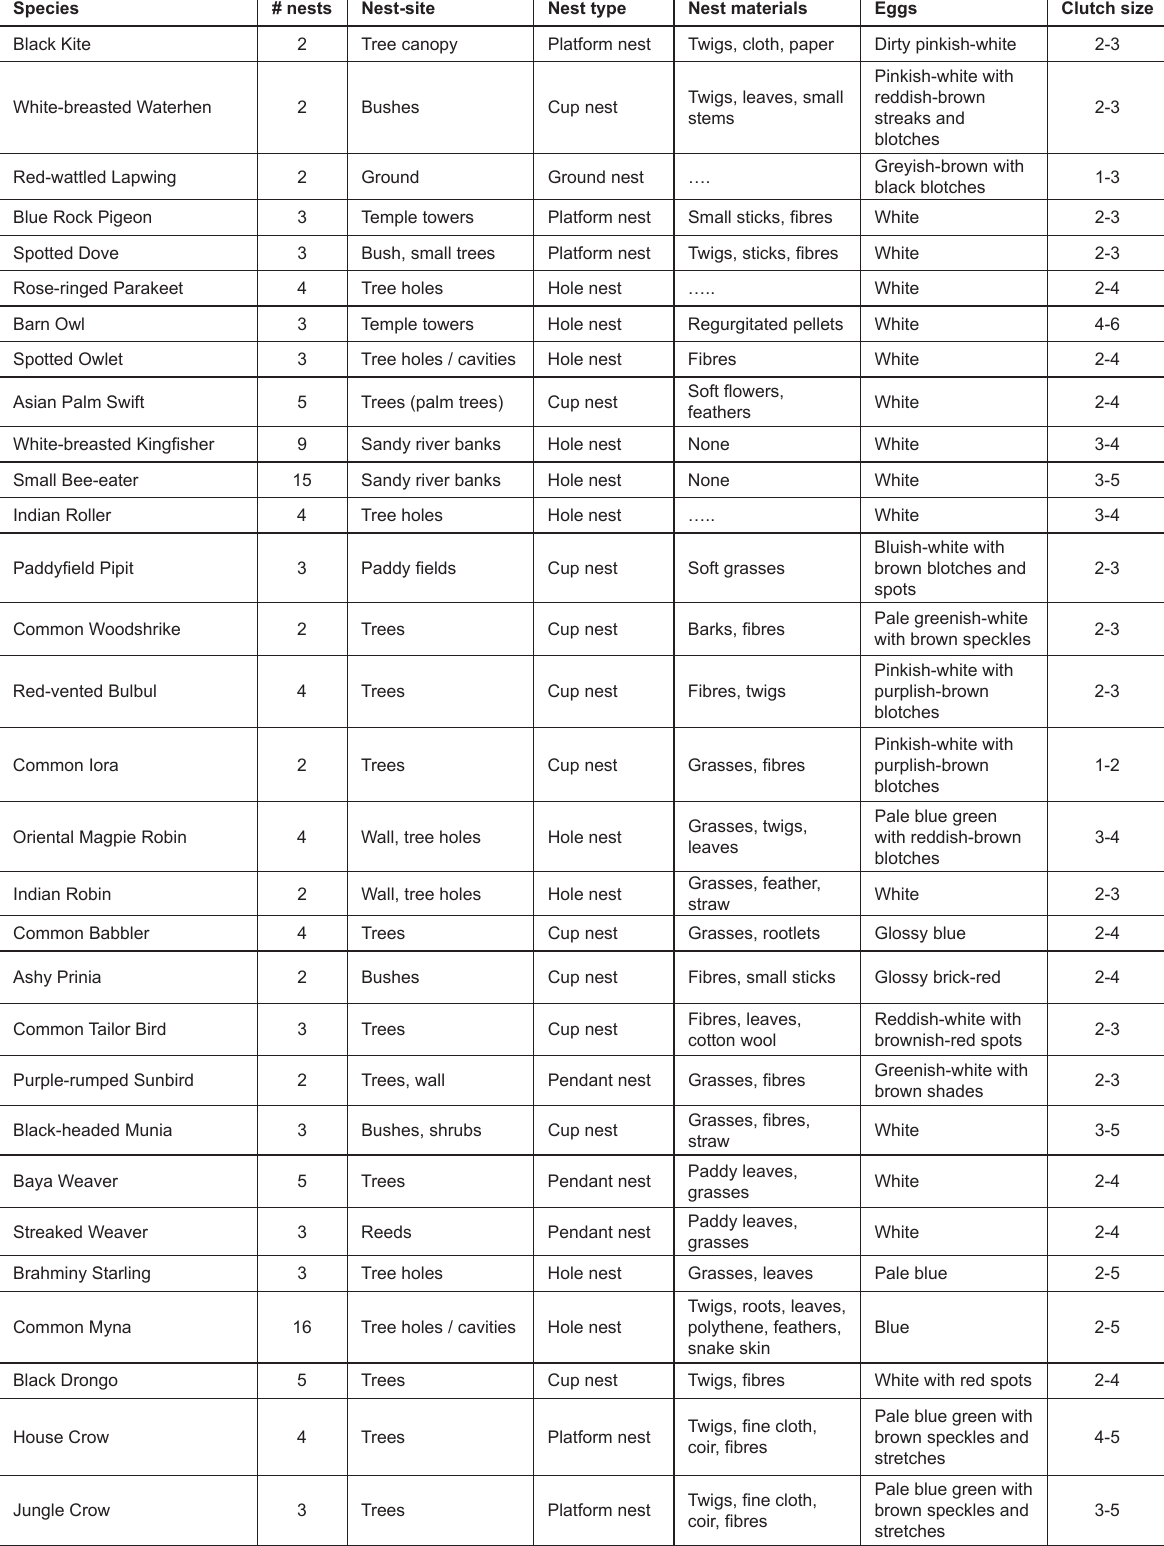
Trees Platform nest